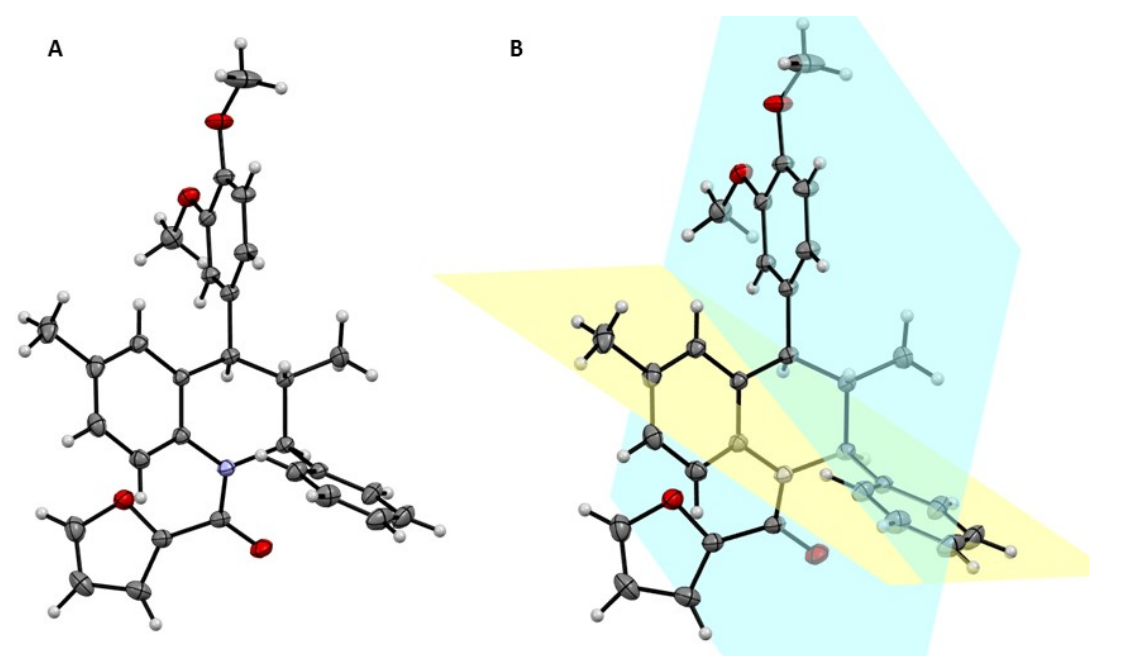
Figure 2. ( A ) ORTEP view of the molecular structure of compound ( 6 ) showing the stereochemistry of the THQ ring with the two aromatic rings in pseudo -equatorial conformation (thermal ellipsoids at 25% level). ( B ) Planes between aromatic rings that are part of its structure. CCDC 2184176 deposition number.